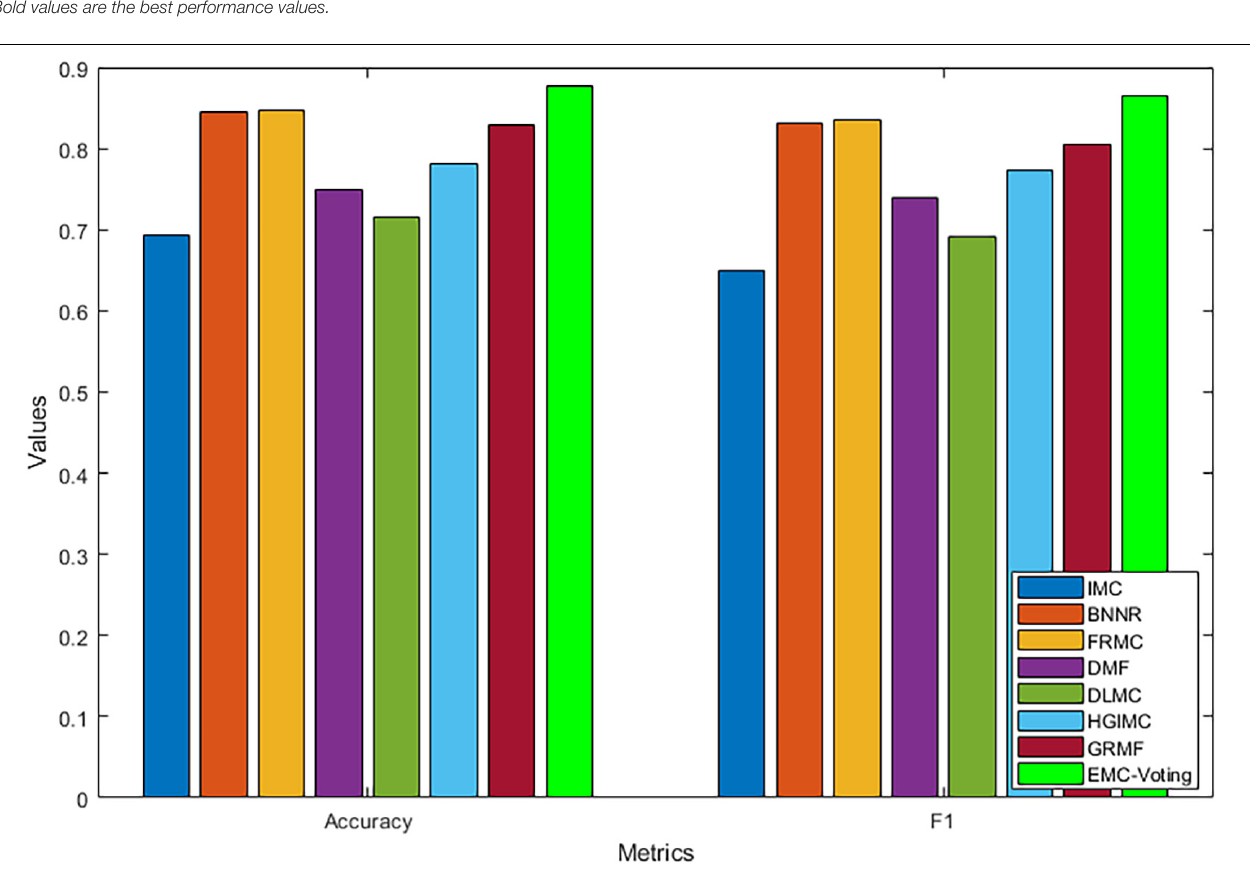
FIGURE 3 | Comparison of performance of different prediction models by Accuracy and F1